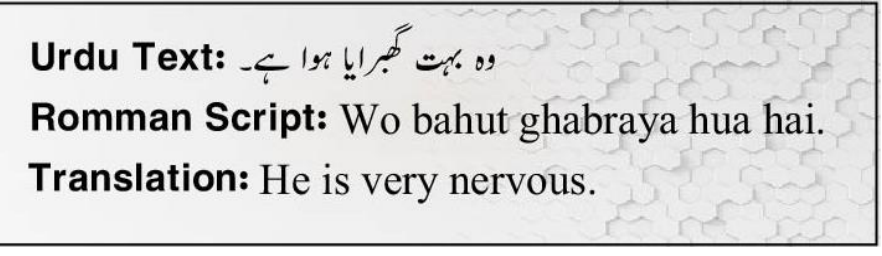
Figure 1. Translation from Urdu to Roman Urdu and English.